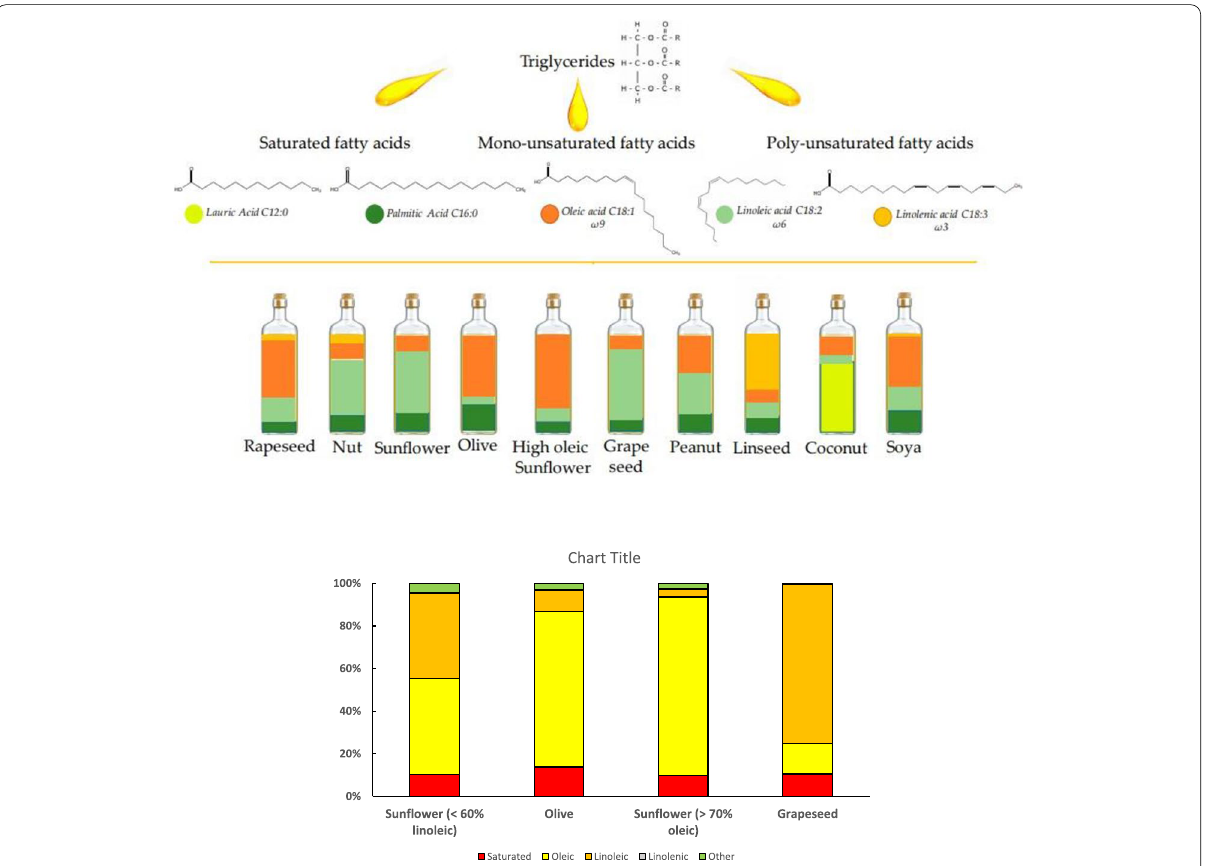
Fig. 2 Vegetable oils composition by fatty acid profile, inspired by Yara-Varón et al.